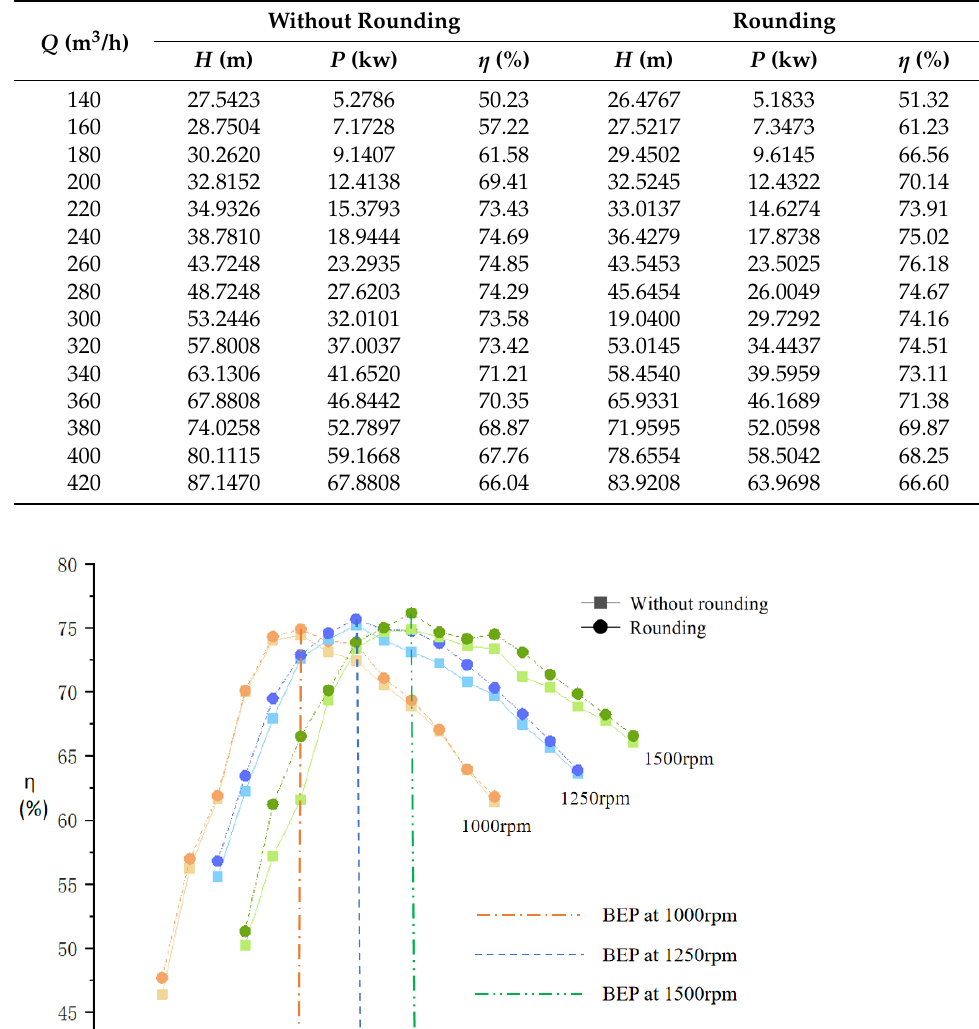
Table 5. Comparison of PAT without rounding and with rounding at 1500 rpm.